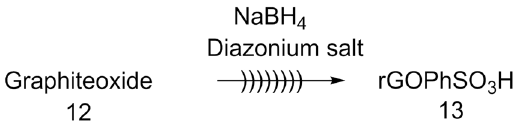
Figure 3. Synthesis of sulfonated reduced grapheneoxide.